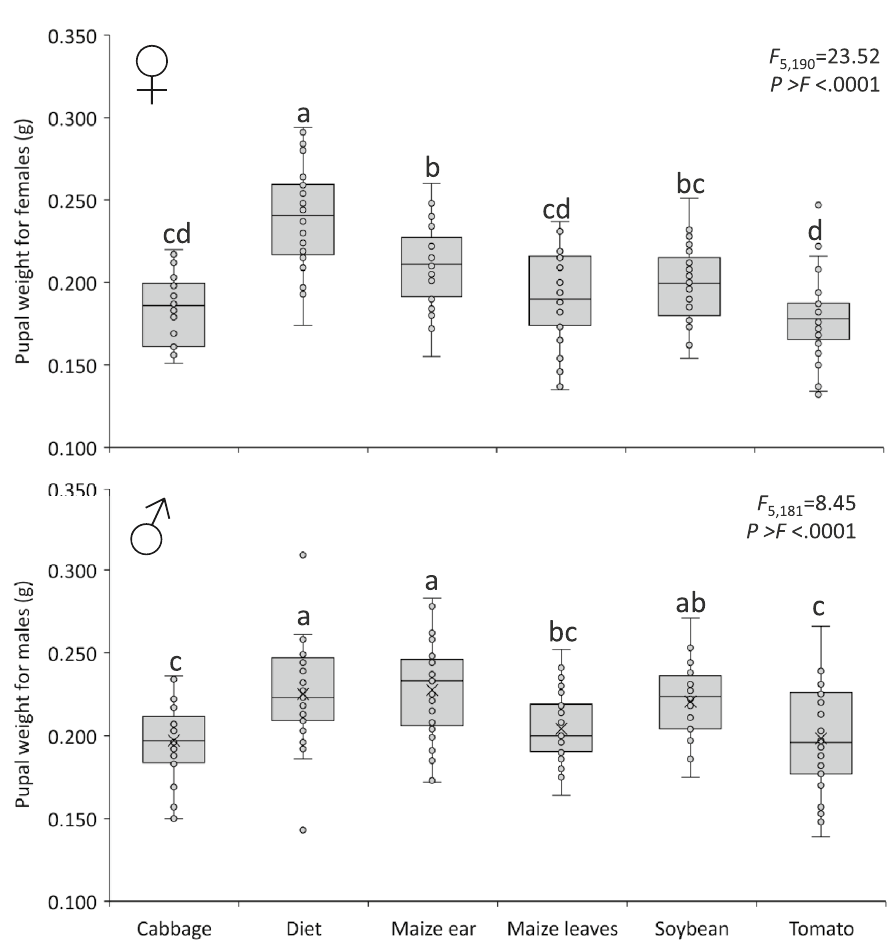
Figure 3. Pupal weight (mean ± SE) for females (top) and males (bottom) of the fall armyworm, Spodoptera frugiperda fed on cabbage, maize ear, maize leaves, artificial diet, soybean, and tomato.